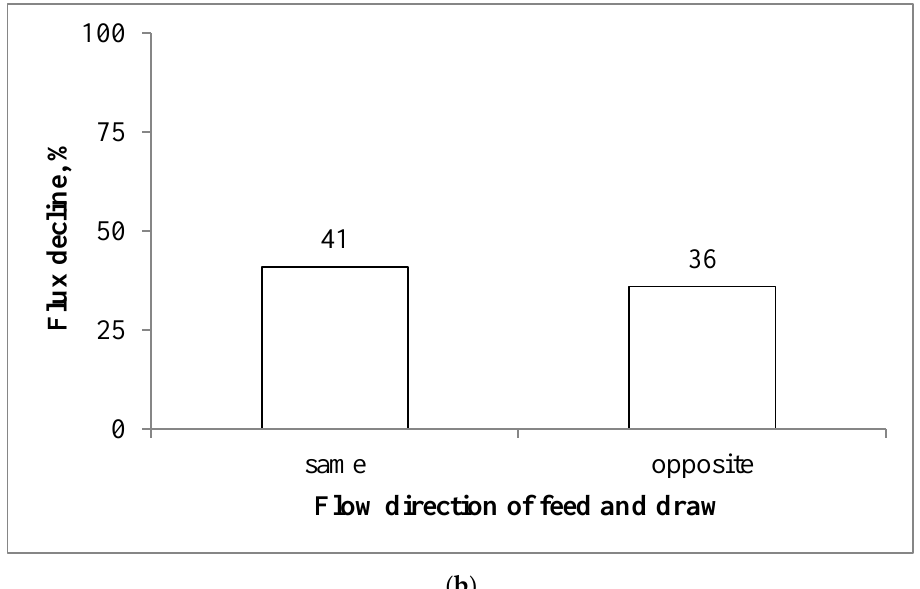
Figure 7. The decline in the flux observed for the scaling experiments: ( a ) effect of the cross-flow velocity; and ( b ) influence of the flow direction. Experimental conditions: concentrations of NaCl, CaCl 2 , and Na 2 SO 4 are 1.754, 6.132, and 4.487 g/L, respectively; SI = 2.45; and an AL-FS orientation.